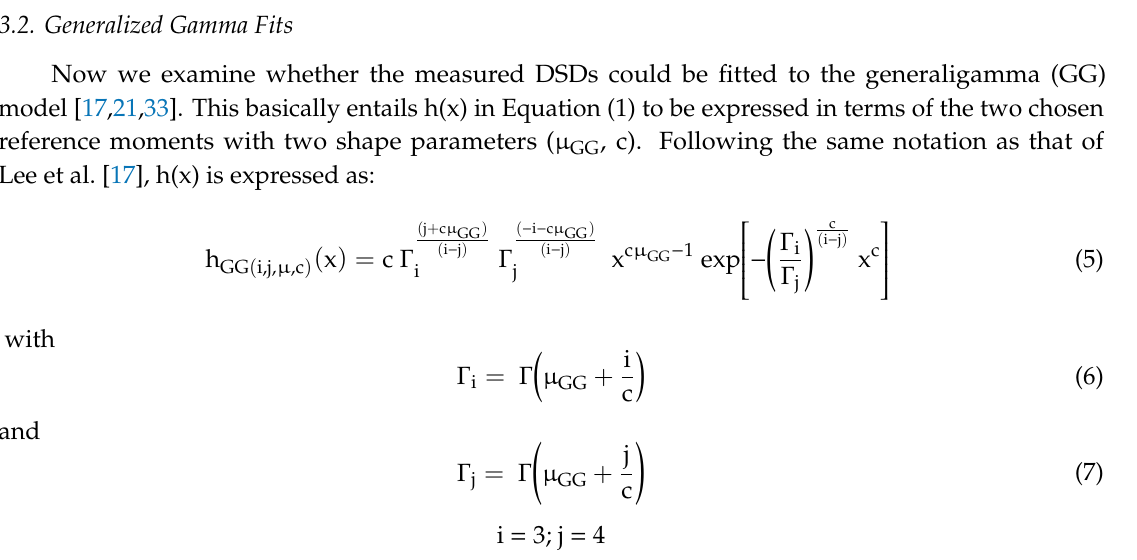
Figure 5d at 18:00 UTC corresponds to the near end of the rainbands over the disdrometer site. A decrease in drop concentration was seen below 1 mm drop diameter. A similar feature was observed during tropical depression Nate over HSV, again towards the end of the event (for an example, see Figure 7d of [35]). One reason for this could be an intrusion of drier air behind the rainbands causing significant evaporation of small drops. The MRR plot shows the reflectivity profiles becoming shallower with time. The fitted GG curve closely represented the measured DSD, but the fitted µ value was significantly positive ( > 2) reflecting the convex down shape at the small drop end, and the fitted c-value was around 1.8, which was lower than the c = 4 derived for the GXY-HSV datasets. Hence, for such cases, one would not expect the composite underlying shape to accurately represent the